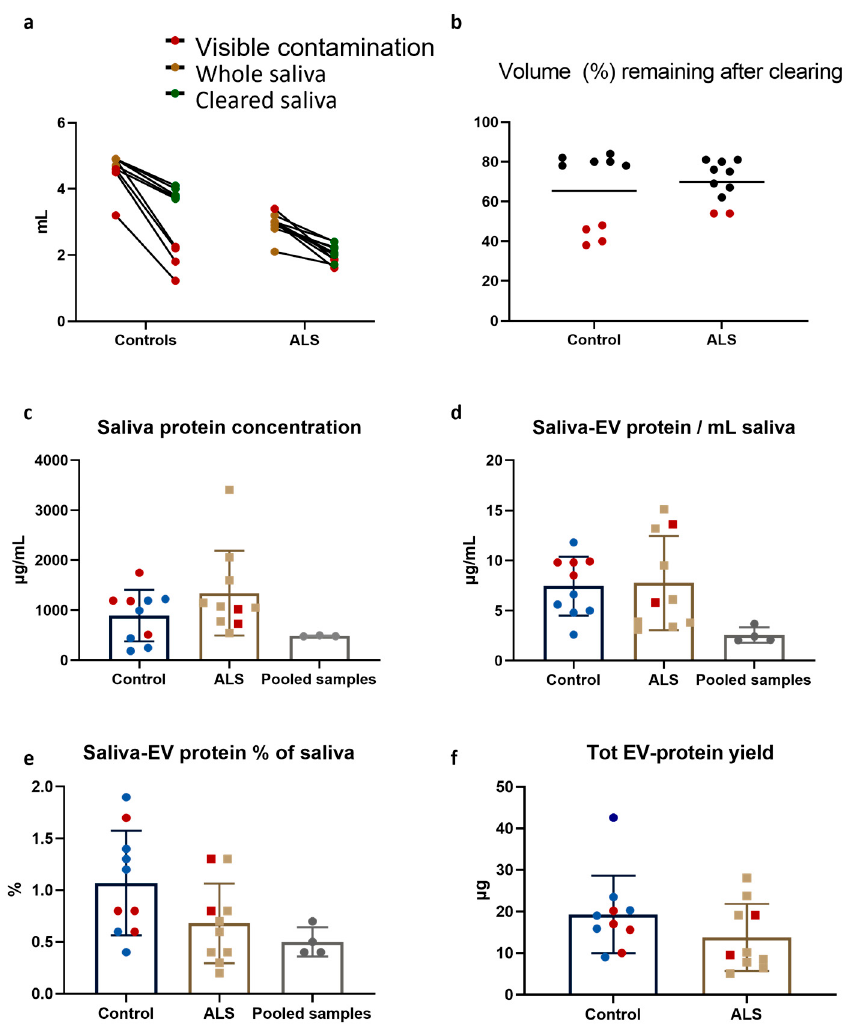
Figure 5. EV-isolation from patient and control saliva samples. ( a ) The starting volume and volume of cleared saliva for controls and ALS samples are plotted. Yellow dots represent whole saliva, green dots cleared saliva and red dots saliva with visible contamination. ( b ) Approximately 65% and 70% of the starting volume remained after clearing of control and ALS samples, respectively. A greater reduction was observed for contaminated samples (red dots) compared to non-contaminated samples (black dots). ( c , d ) The total protein concentrations in saliva ( c ) and saliva-EVs isolated from one milliliter saliva ( d ) were similar between the two groups, and within the range of pooled samples. ( e ) The EV-isolates represented approximately 0.75% of the total saliva protein concentration, with no significant difference between the sample groups and within the range of pooled samples. ( f ) The total EV-protein yield ranged from 42.6 µg to 5.1 µg, with no difference between the groups. For ( c – f) : blue dots represent control samples, yellow squares ALS samples and gray dots pooled samples. Red dots or squares indicate samples with visible contamination. Error bars represent standard deviation. There was no clear distinction between the two groups of saliva-EVs based on PCA, and there was no indication that contamination affected the analysis (Figure 6a). There were no significantly differentially expressed proteins, but a trend for a decrease in ZNF428 in ALS saliva-EVs was observed (Figure 6b,c). Similarly, for the saliva samples, there was no clear clustering in the PCA plot (Figure 6d) and no differentially expressed proteins, but a trend for an increase in IGLL1 in ALS patients was found (Figure 6e,f). Peptide information regarding ZNF428 and IGLL1 is included in the Supplementary In- formation.